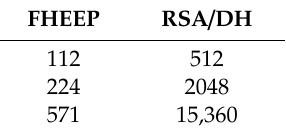
Table 1. Showing a key comparison of ECC, RSA, and DH.